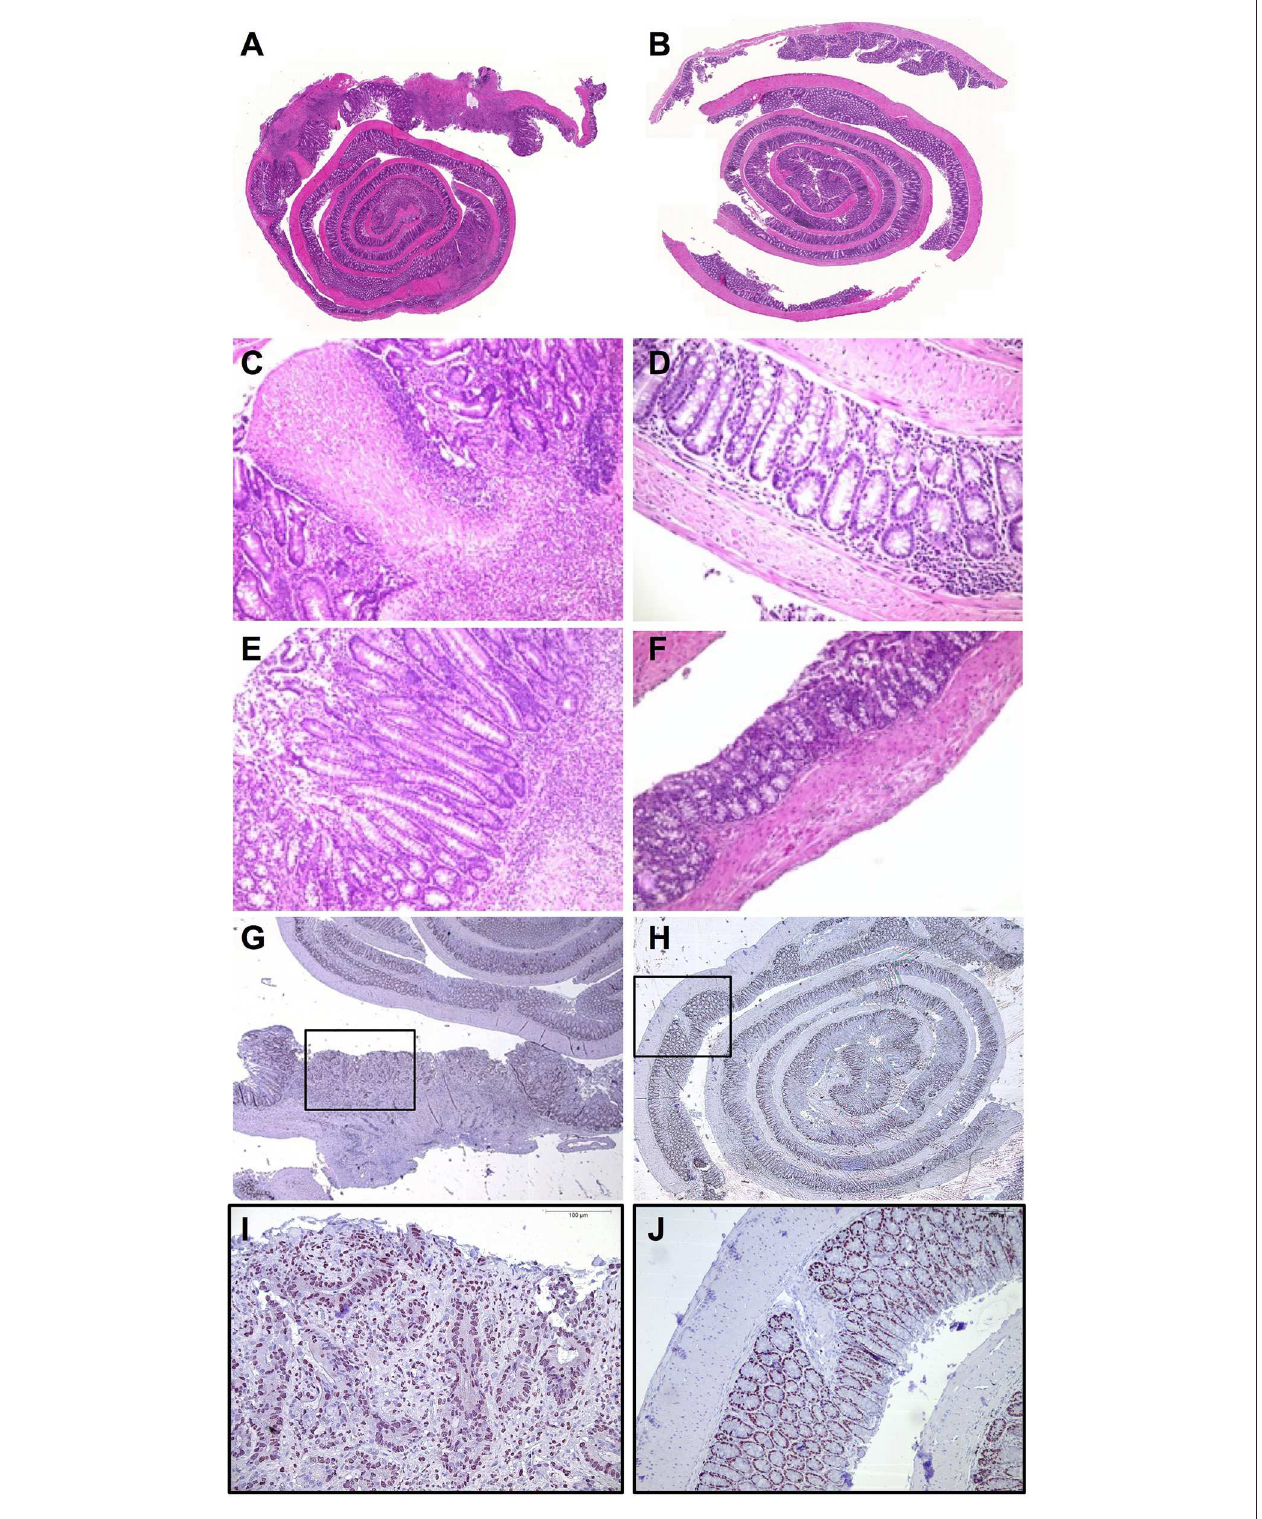
FIGURE 4 | Reduced inflammation and colon carcinogenesis in IL-10KO/IL-37tg mice in the course of chronic colitis. Whole explanted colons from IL-10KO mice (A) and IL-10KO/IL-37tg mice (B) were rolled up from distal to proximal (“swiss role”), transferred to formaldehyde solution for 24h and subsequently embedded in